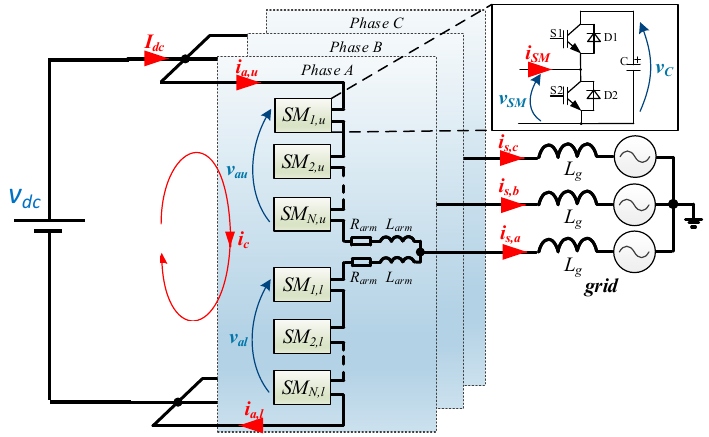
Figure 1. Schematic representation of a three phase grid connected Modular Multilevel Converter (MMC).